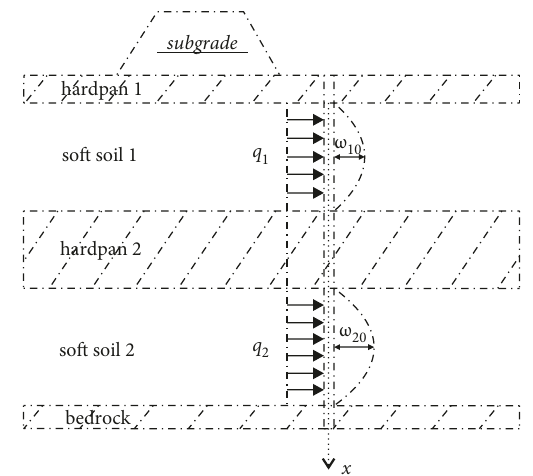
Figure 6: Stress analysis of the inclinometer with hard interlayer in